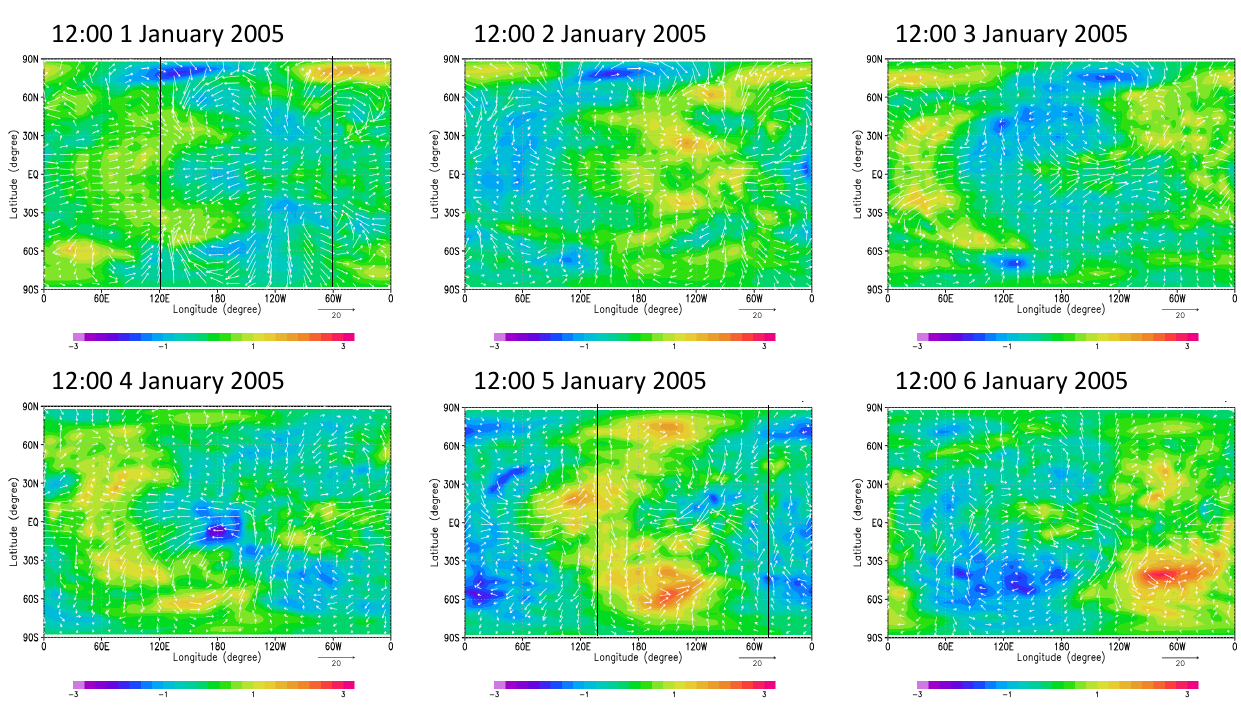
Figure 4. Time variations of temperature (color) and wind velocity (vector) deviations from their zonal averages in latitude-longitude cross sections at 70 km for the case of z70l15h6